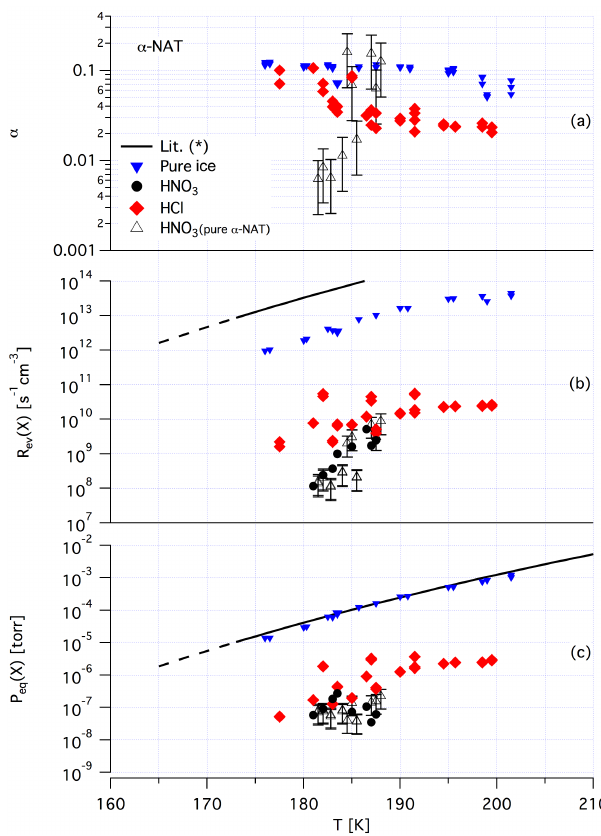
Figure 9. Synopsis of kinetic results for β -NAT using HCl as a probe gas in PV experiments. The symbols used are coded in the up- per panel. The calculated relative error for PV experiments is 30%. The black line shows results from Marti and Mauersberger